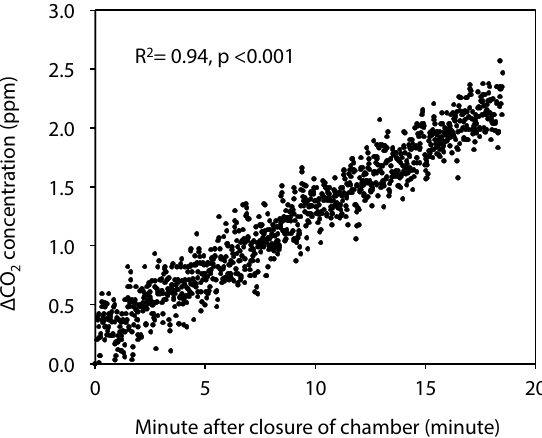
Figure 3. Example of the temporal variation in CO 2 concentration ( (cid:49) CO 2 ) in the chambers installed at station YI1 that is use to calcu- late the CO 2 flux. (cid:49) CO 2 indicates the change in CO 2 concentration inside the chamber since the chamber was